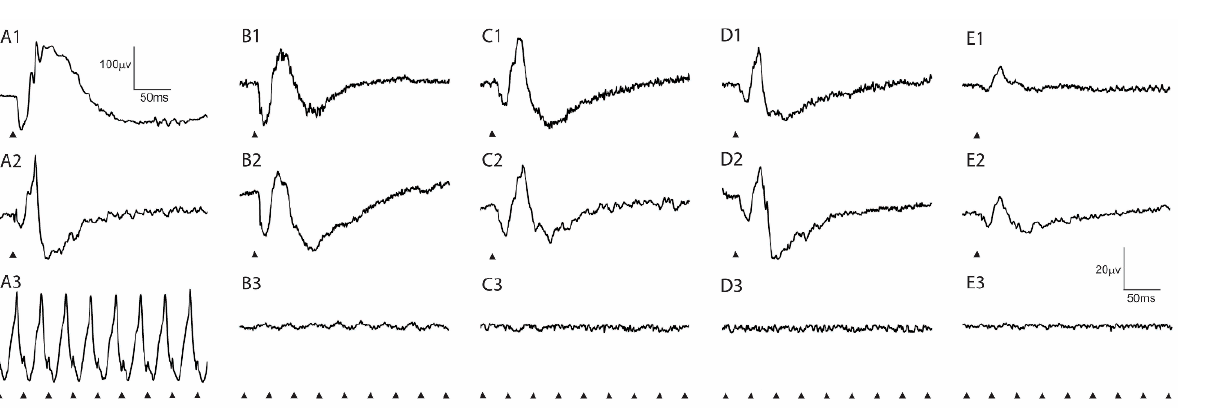
Figure 4. Mean (± SD) ERG amplitude stimulus–response plots in dark- and light-adapted eyes. In each instance, the insert compares the mean wild-type amplitudes of wild-type controls with the 2–3-month-old Rpe65-deficient dogs (note differ- ence in response threshold between wild-type and Rpe65-deficient dogs). ( A , B ) Dark-adapted and ( C , D ) light-adapted mean a-wave ( A , C ) and b-wave ( B , D ). Note that amplitudes reduce significantly with age (* indicates flash stimuli with a significant change in amplitude [ p < 0.05] with age) <3 months, n = 8 eyes; 3–12 months, n = 34 eyes; 12–60 months, n = 28 eyes; 60–96 months, n = 8 eyes. Wild-type control dogs: 9–12 months, n = 10 eyes. It should be noted that at the standard flash intensity used for light-adapted cone flicker, the single-flash light-adapted response in Rpe65-deficient dogs was also of a very low amplitude.